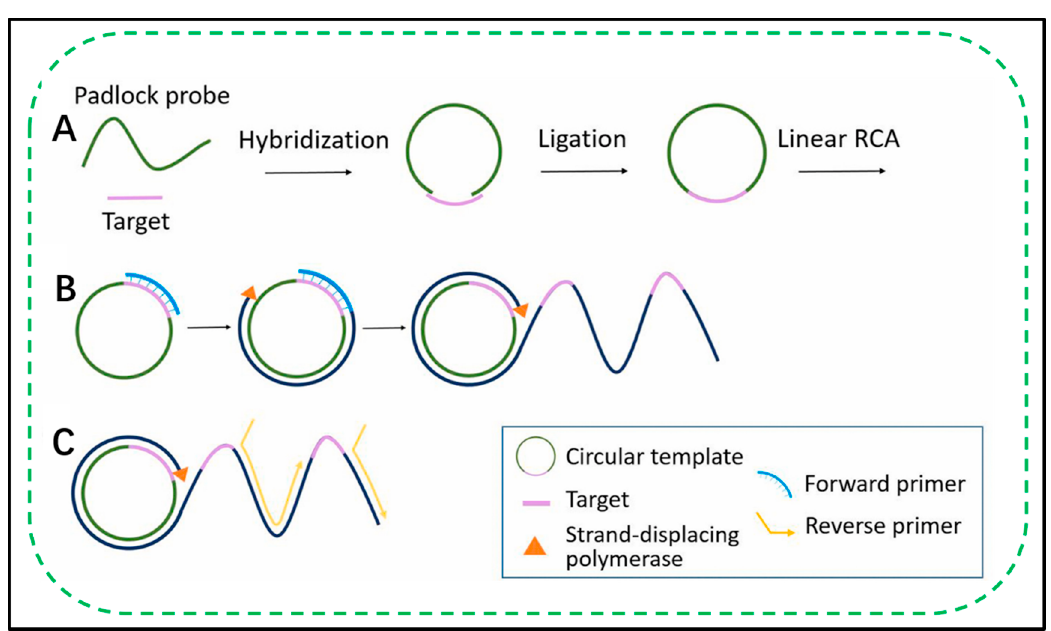
Figure 1. Schematics of RCA mechanisms. ( A ) Ligation RCA. ( B ) Linear RCA. ( C ) Hyperbranched RCA. Adapted with permission from ref. [50].